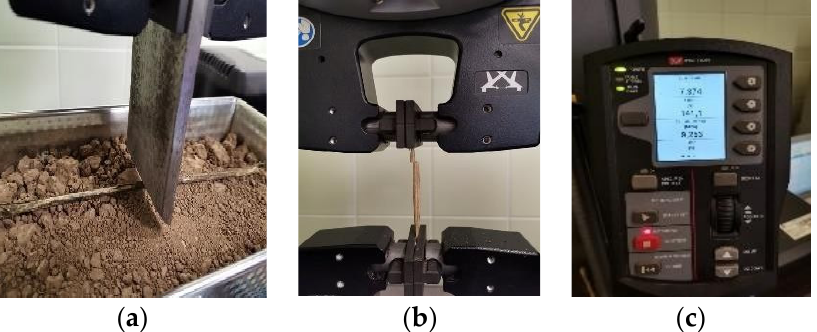
Figure 2. Studies on the mechanical properties of the cannabis residue: ( a ) cutting in the soil, ( b ) breaking, ( c ) control